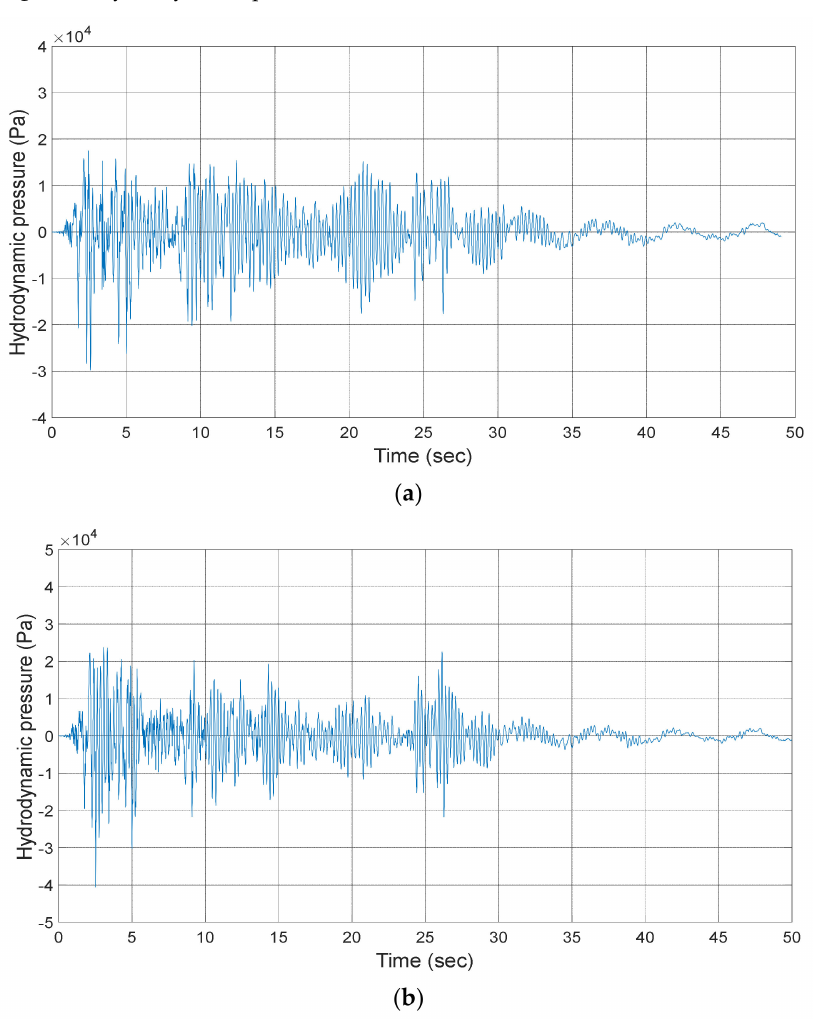
Figure 9. Time histories of hydrodynamic pressure when the incident angle of the input ground motion is zero: ( a ) Nonlinear analysis; ( b ) Linear